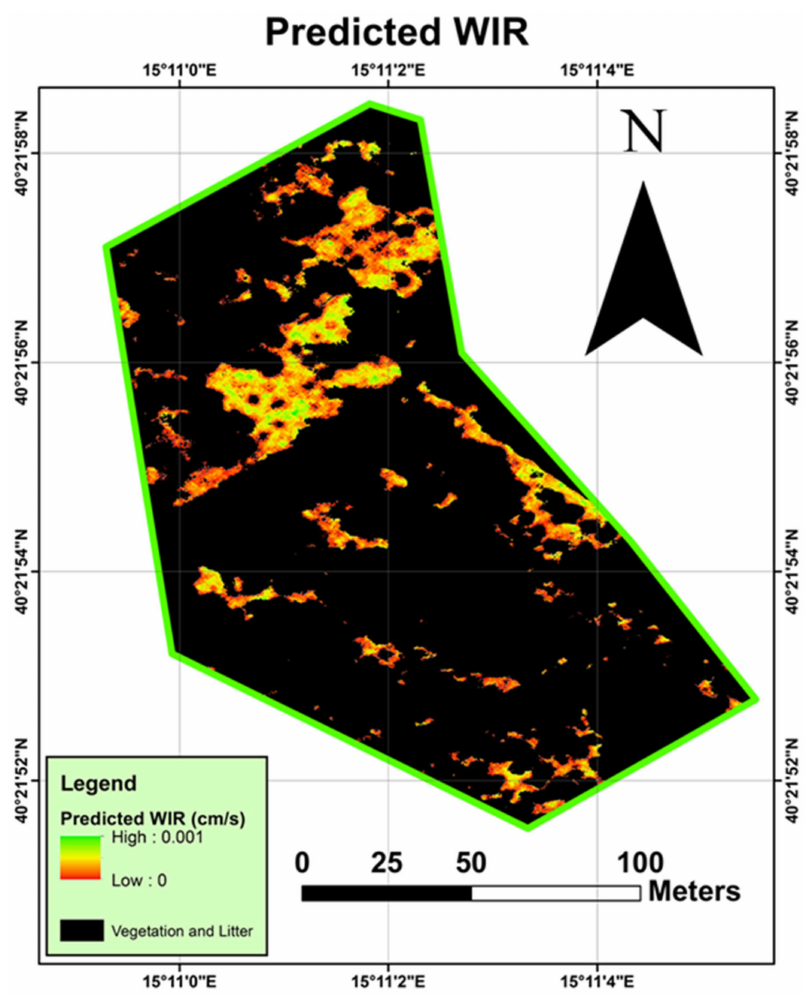
Figure 13. The predicted WIR values over the exposed soil pixels and the masked pixels that represent vegetation and/or